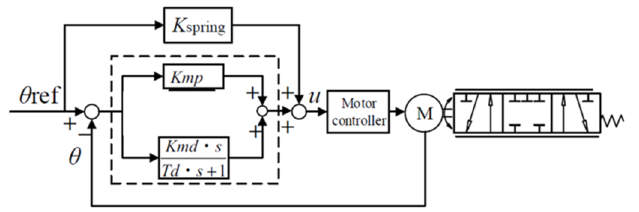
Figure 12. Frequency response of cam angle control at 500 kPaG. Table 1. Gain parameters of cam angle control.